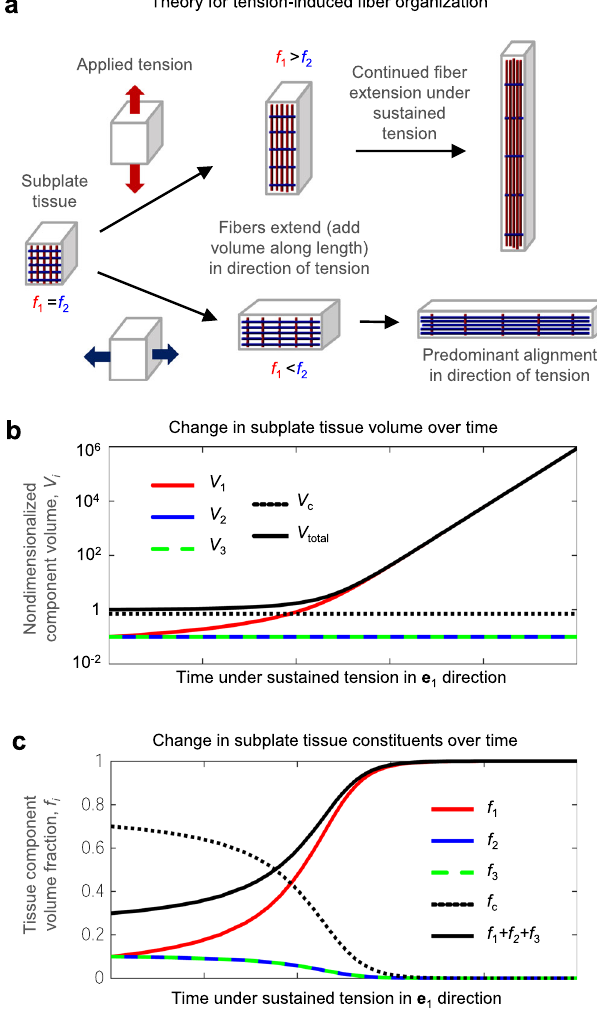
Fig. 8 Theoretical growth and remodeling in response to sustained tension. a Schematic illustration of tissue elements with embedded fi bers in initial con fi guration (left), after a short period of stretch and fi ber elongation (middle), and after an extended period of stretch and fi ber elongation (right). Tissue blocks are not shown to scale since volume increase becomes dramatic over an extended period of stretch. Theoretical behavior of a tissue element subjected to sustained tension in direction e 1 as time approaches in fi nity is described in b – c . b Volume associated with each tissue component as a function of time, starting from a nondimensionalized total tissue volume ( V total ) of 1. V 1 represents volume associated with fi bers aligned in the direction of tension ( e 1 ), while V 2 and fi bers perpendicular to tension ( e V 3 represent the volume associated with 2 and e 3 ), and V c represents the volume associated with cells and extracellular matrix. Vertical axis is log scaled to facilitate visualization, as total volume begins to increase dramatically (approximately exponentially) at later time points. c Volume fraction of each tissue component as a function of time, starting from an initial fi ber volume fraction of 10% in each direction ( f 1 = f 2 = f 3 = 0.1). When tension and fi ber growth are allowed to continue inde fi nitely, fi ber volume fraction approaches 1 while the volume fraction of non- fi ber components ( f c ) approaches